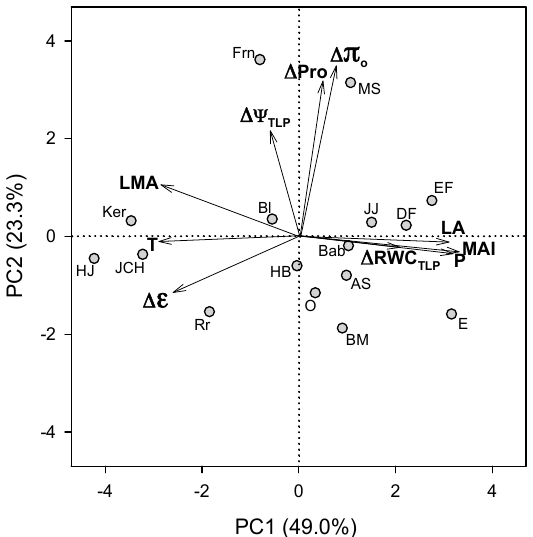
Figure 6. Relationships between the first two principal components (PC1 vs. PC2) of the principal component analysis (PCA) computed on leaf mass per area (LMA), leaf area (LA), climatic variables, and change ( Δ ) between control and water stressed seedlings in proline concentration and in the pressure–volume relationships, for the 16 Quercus suber populations. Population codes are as in Table 1. P, annual precipitation; T, mean annual temperature; MAI, De Martonne aridity index; Δπ o , change in osmotic potential at full turgor; ΔΨ TLP , change in water potential at turgor loss point; Δ RWC TLP , change in relative water content at turgor loss point; Δε , change in bulk modulus of elasticity; Δ Pro, change in proline concentration.